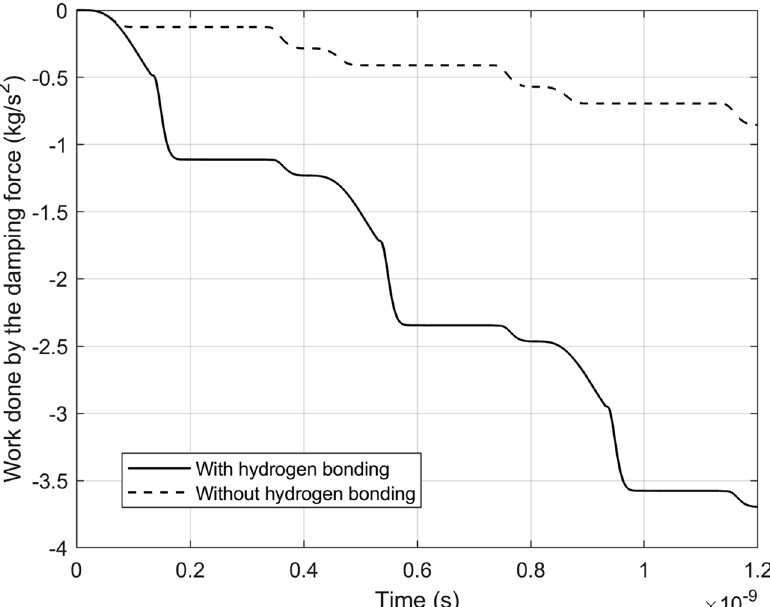
Figure 4. The work done by the damping force (per unit area) with and without hydrogen bonding participating in the simulations in Fig. 2b,c.